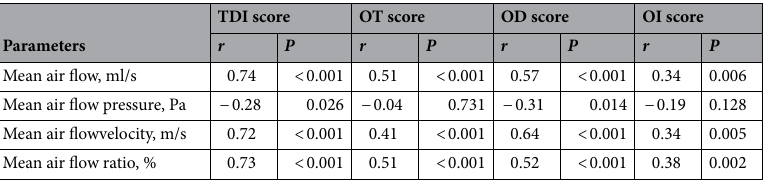
Table 2. Results of the correlation of flow parameters in the olfactory cleft areas with the olfactory